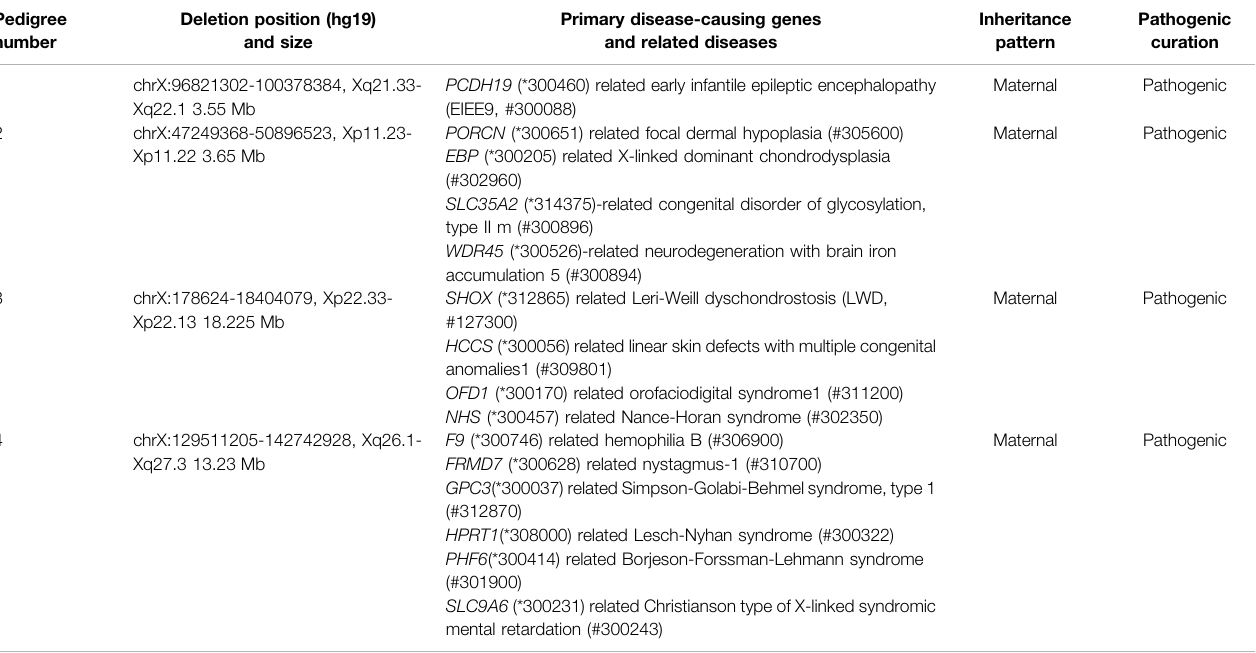
TABLE 1 | Summary of the X-linked deletions carried by four pedigrees. Pedigree Deletion position (hg19) number and